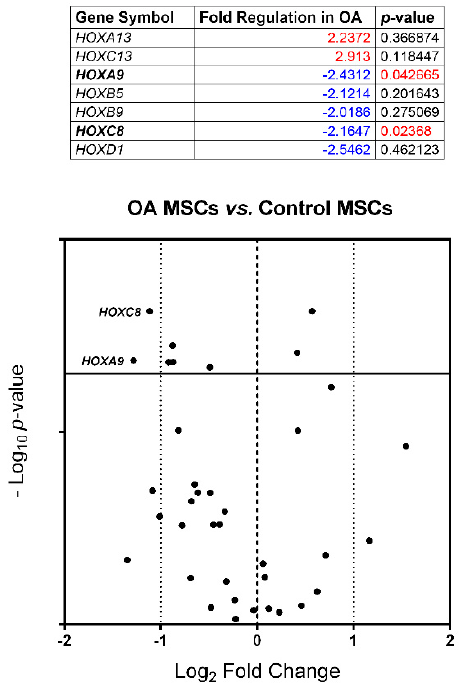
Figure 2. Numerical results and Volcano plot representation of HOX genes global expression. Genes upregulated and downregulated (negative values) in OA-Mesenchymal stem cells (MSCs) compared to Control-MSCs with fold differences greater than 2; p -values below 0.05 were considered statistically significant. The dashed lines indicate the expression boundaries. The solid lines indicate the 0.05 p -value threshold.